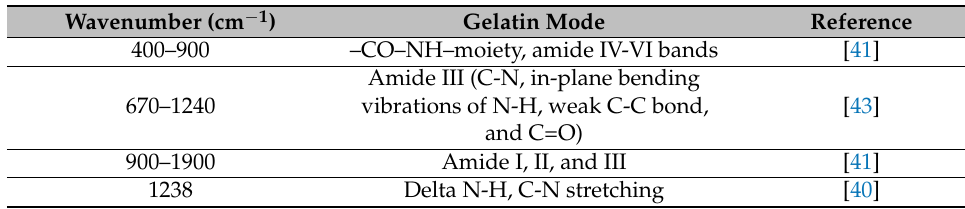
Table A1. Major FTIR absorption peaks for gelatin and PVA